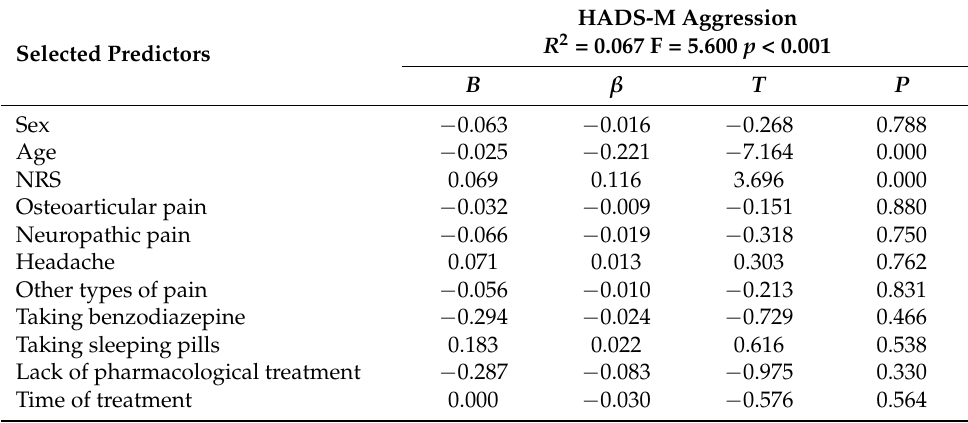
Table 5. Regression analysis for the HADS-M: